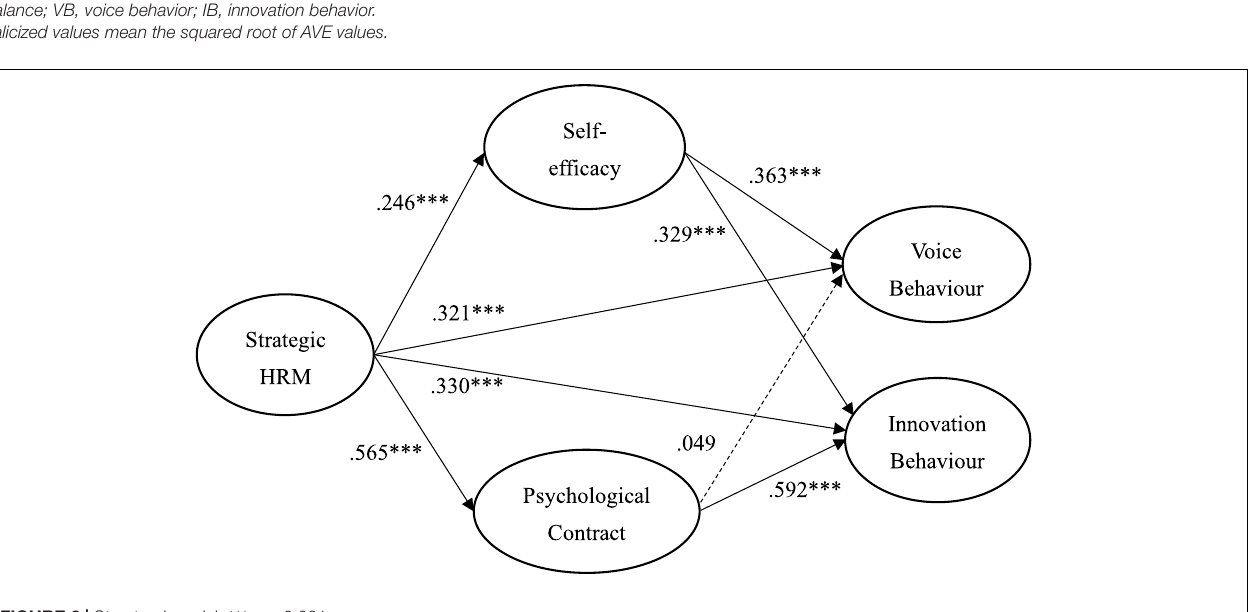
FIGURE 2 | Structural model. ∗∗∗ p <